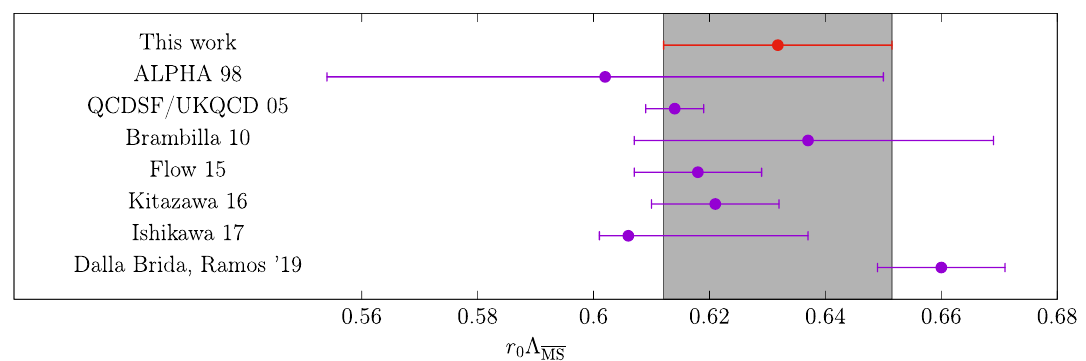
Fig. 5 Continuum extrapolation of the reference scale μ had in units of t 0 and r 0